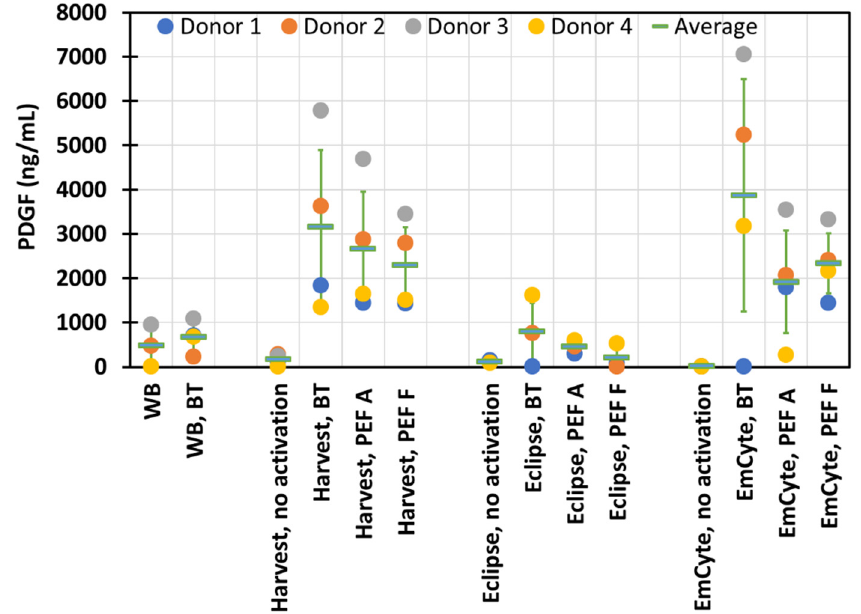
Figure 4. PDGF release for: whole blood (WB)—no activation and bovine thrombin (BT) activation; Harvest PRP (no activation, bovine thrombin—BT-activation, and activation using electric stimulation with pulses A and F); Eclipse PRP (no activation, bovine thrombin—BT-activation, and activation using electric stimulation with pulses A and F); EmCyte PRP (no activation, bovine thrombin—BT-activation, and activation using electric stimulation with pulses A and F). Note that there is no Donor 3 data for Eclipse.